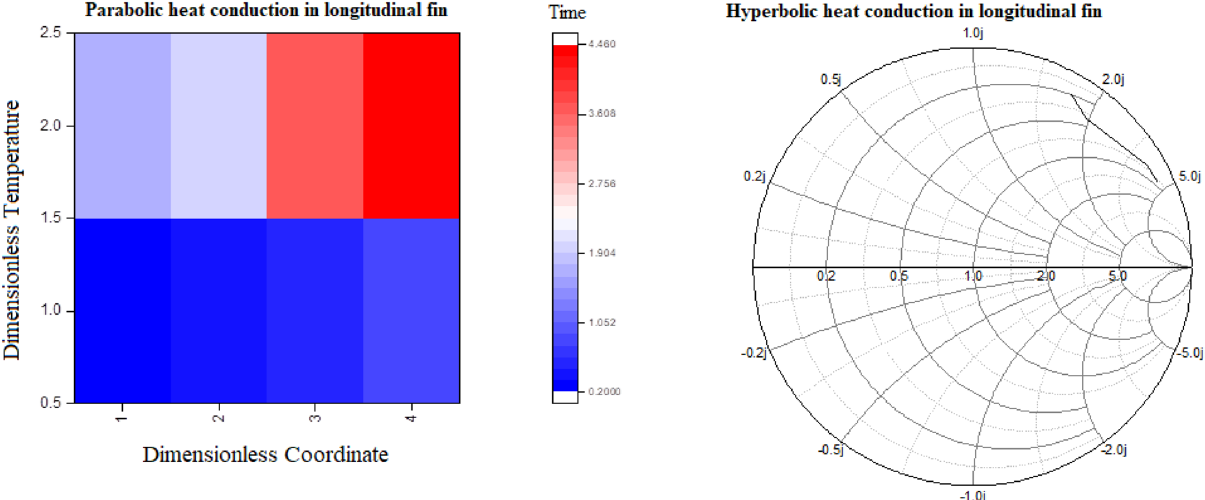
Figure 6. Heat graph of parabolic heat conduction for the variants of time and Smith graph for hyperbolic heat conduction for scatterings of temperature